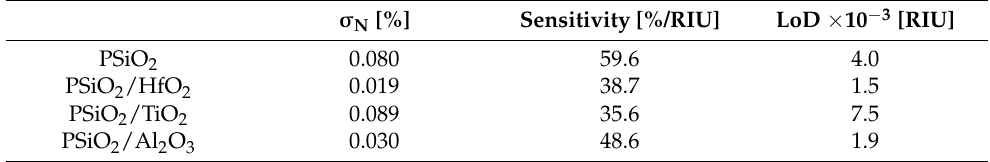
Table 3. Noise level, sensitivity and theoretical limit of detection for the passivated PSi